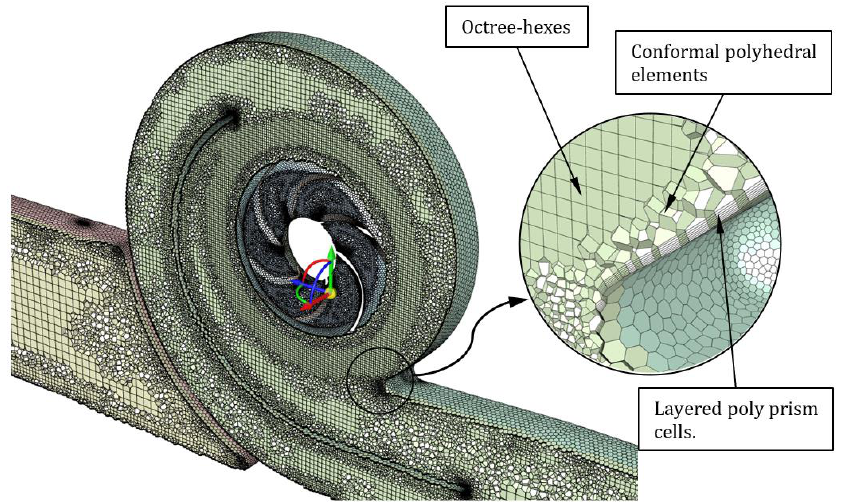
Figure 5. Clipped view of mosaic mesh generated using ANSYS Fluent Mosaic mesh technology.